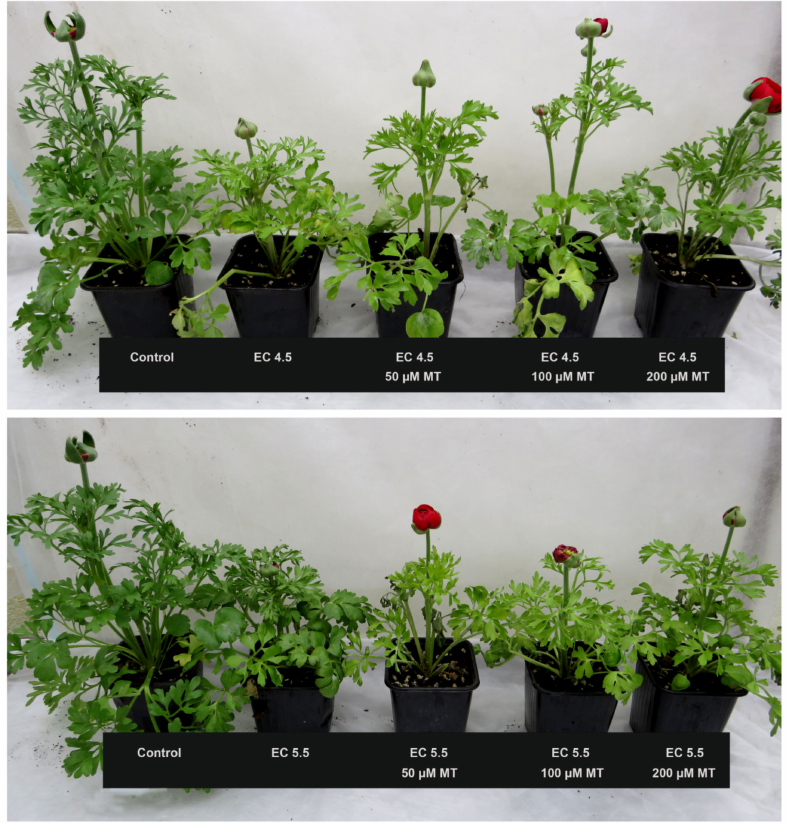
Figure 3. Morphological changes in R. asiaticus plants being treated with different concentrations of exogenous melatonin under salinity